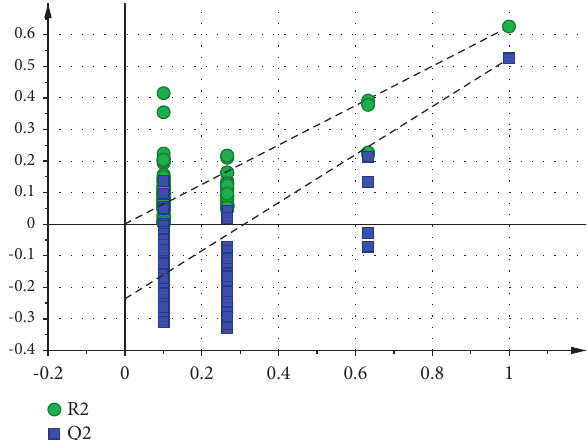
Figure 6: Replacement test of the PLS-DA model for 33 batches of S. divaricata .